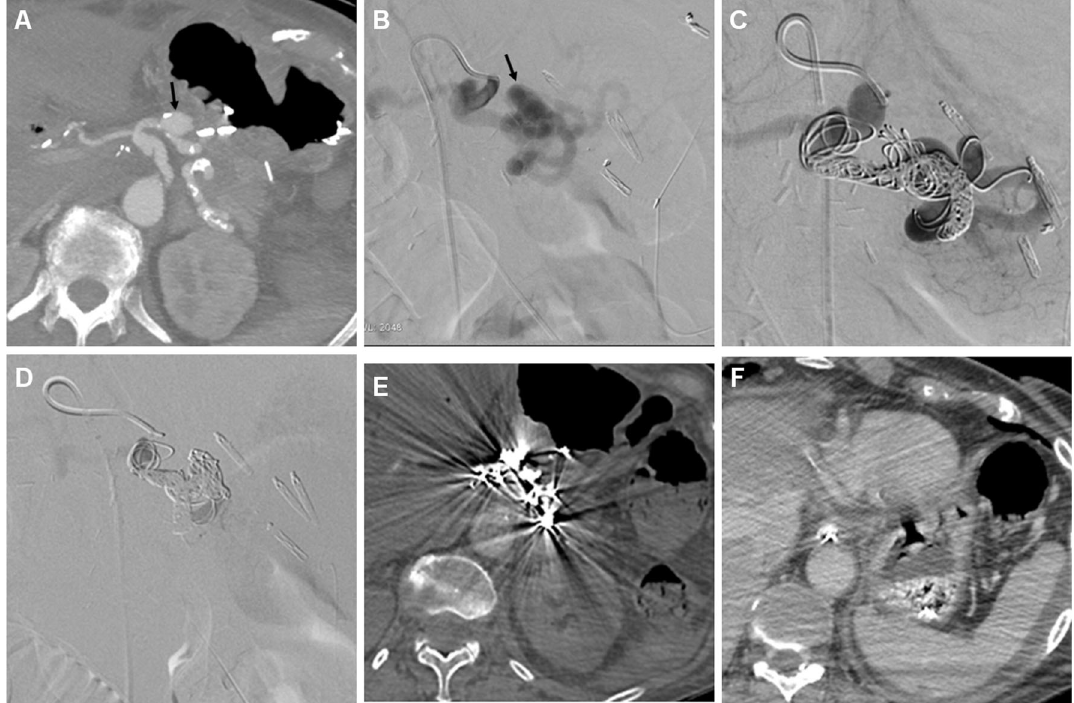
B sandwich technique ^ , placing coils both distally and proximally to the pseudoaneurysm, plus 0.2 ml of glue, due to persistent flow through the coils ( c ). Final angiogram ( d ) confirmed complete exclusion of